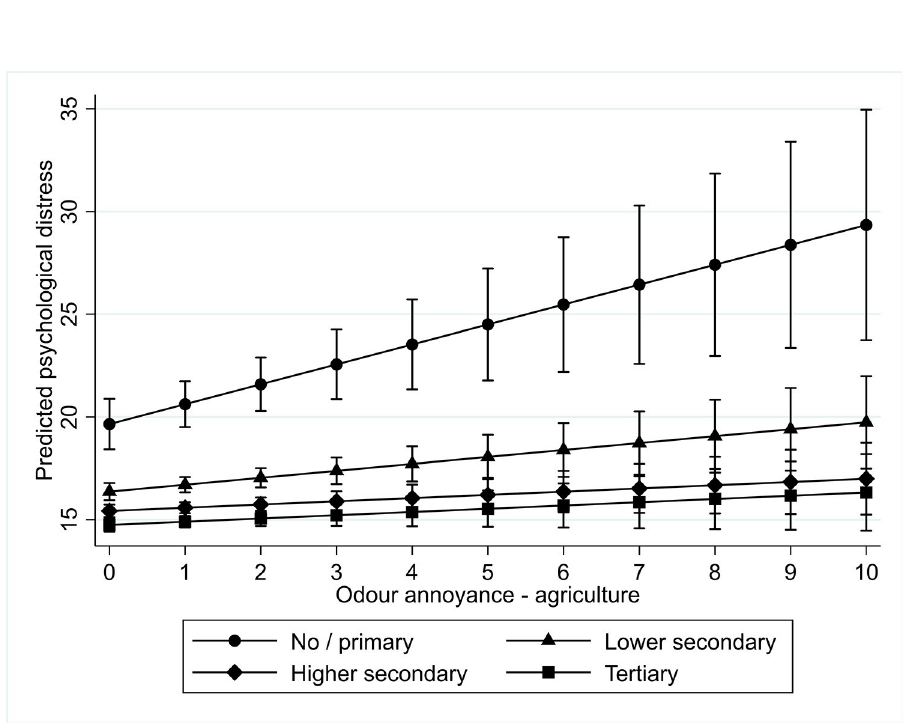
Fig 3. Interaction plot for predicted psychological distress among different educational levels by level of odour annoyance by agriculture.